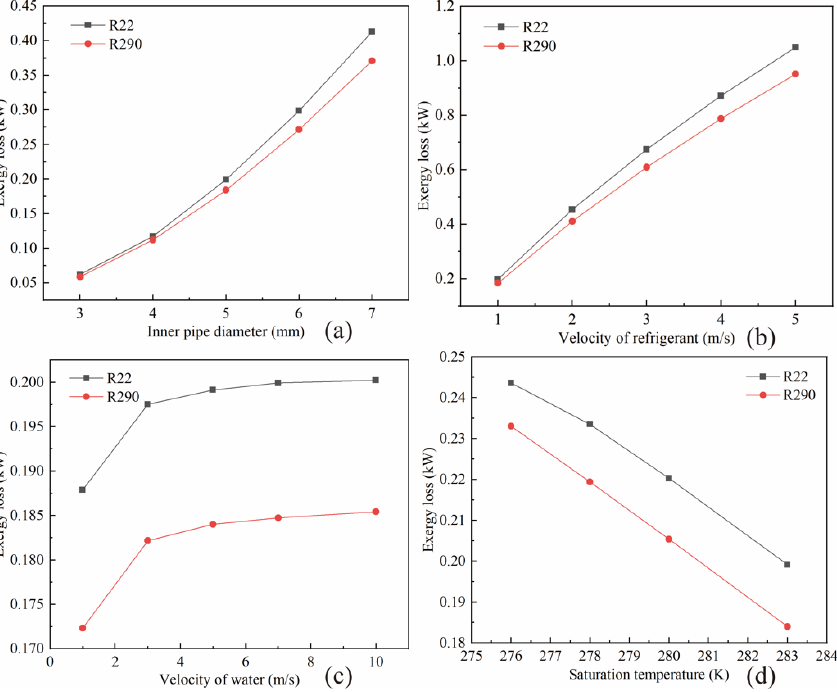
Figure 13. The impact of ( a ) inner pipe diameter, ( b ) refrigerant velocity, ( c ) water velocity and ( d ) saturation temperature on exergy loss.